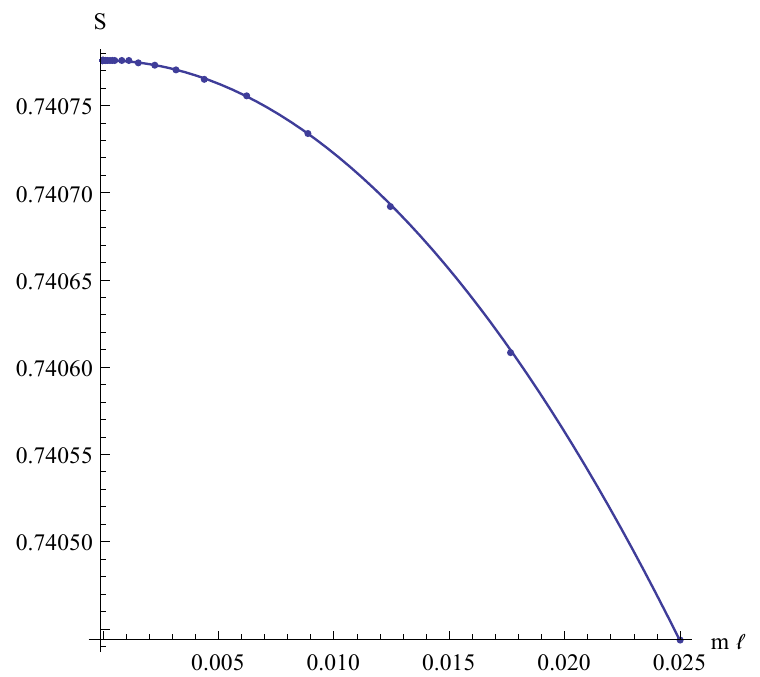
Figure 7 . S vs. ‘=a for a chain of harmonic oscillators with one (cid:12)xed boundary.